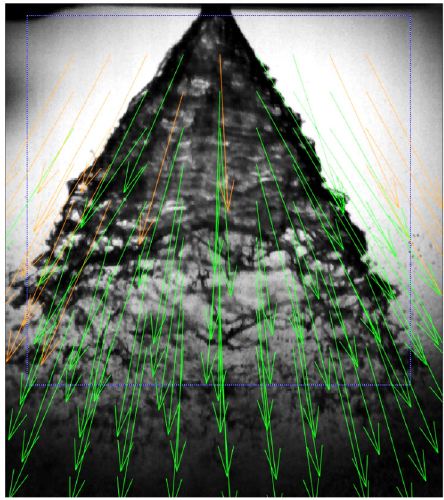
Fig. 6. Velocity vectors from PIVlab software